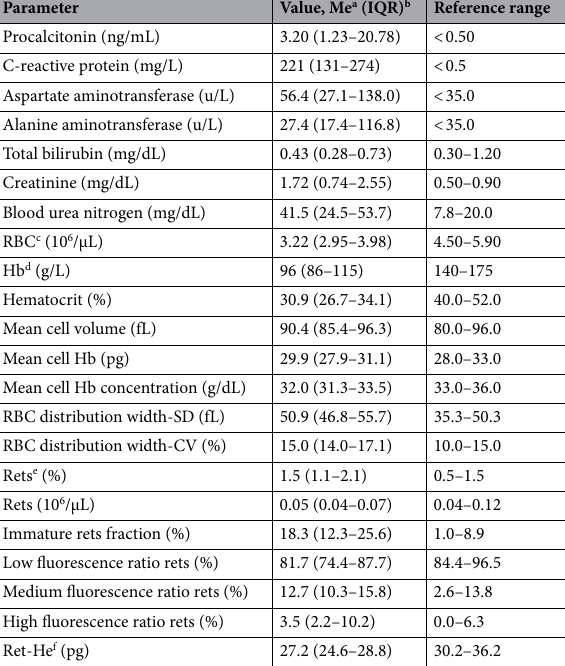
Table 2. Laboratory parameters of the study subjects. a Median value. b Interquartile range. c Red blood cell. d Hemoglobin. e Reticulocytes. f Reticulocyte hemoglobin